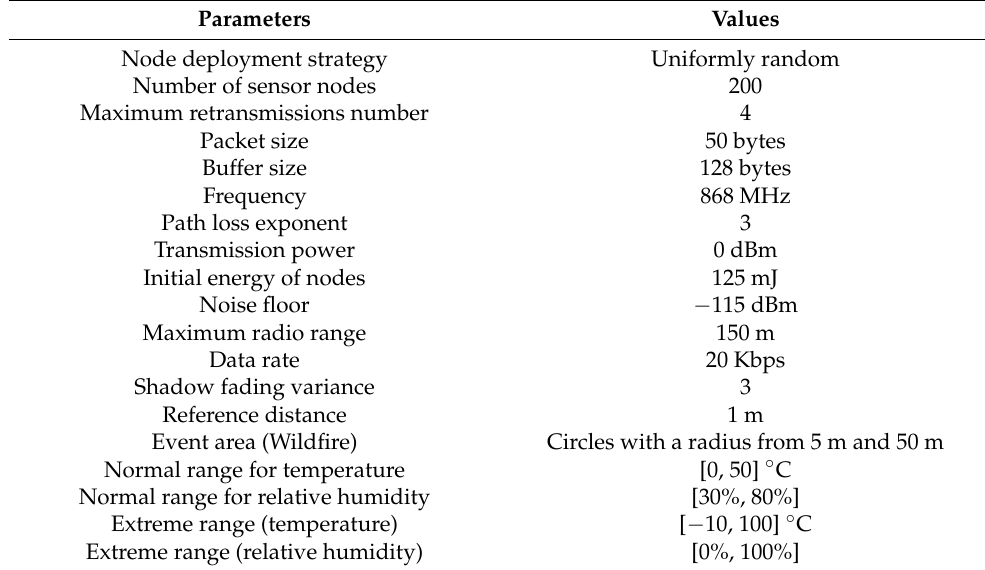
Table 4. Simulation environment